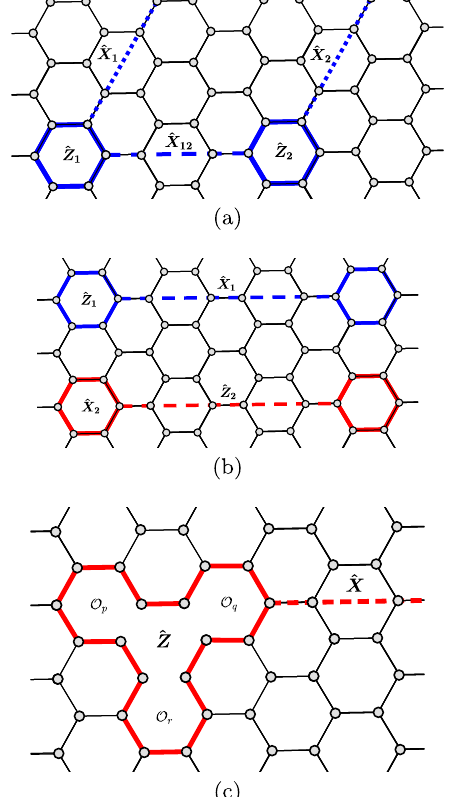
FIG. 6. Logical qubits in the Majorana surface code. In (a) we stop the measurement of two plaquette operators in subsequent surface code cycles, increasing the ground-state degeneracy by a ˆ Z ˆ Z ˆ Z factor of 4. If we take operators for 1 and 2 to be the logical ˆ X ˆ X the two encoded qubits, the corresponding 1 and 2 operators are given by Wilson lines connecting to the boundary. The two qubits may be coherently manipulated by applying the operator ˆ X 12 as shown. In practice, it is simpler to define logical qubits by stopping the measurement of pairs of plaquettes of a single type, ˆ X ˆ Z with the logical and defined as shown in (b). We may also consider a logical qubit made of several “ holes, ” as in (c), to minimize errors during qubit